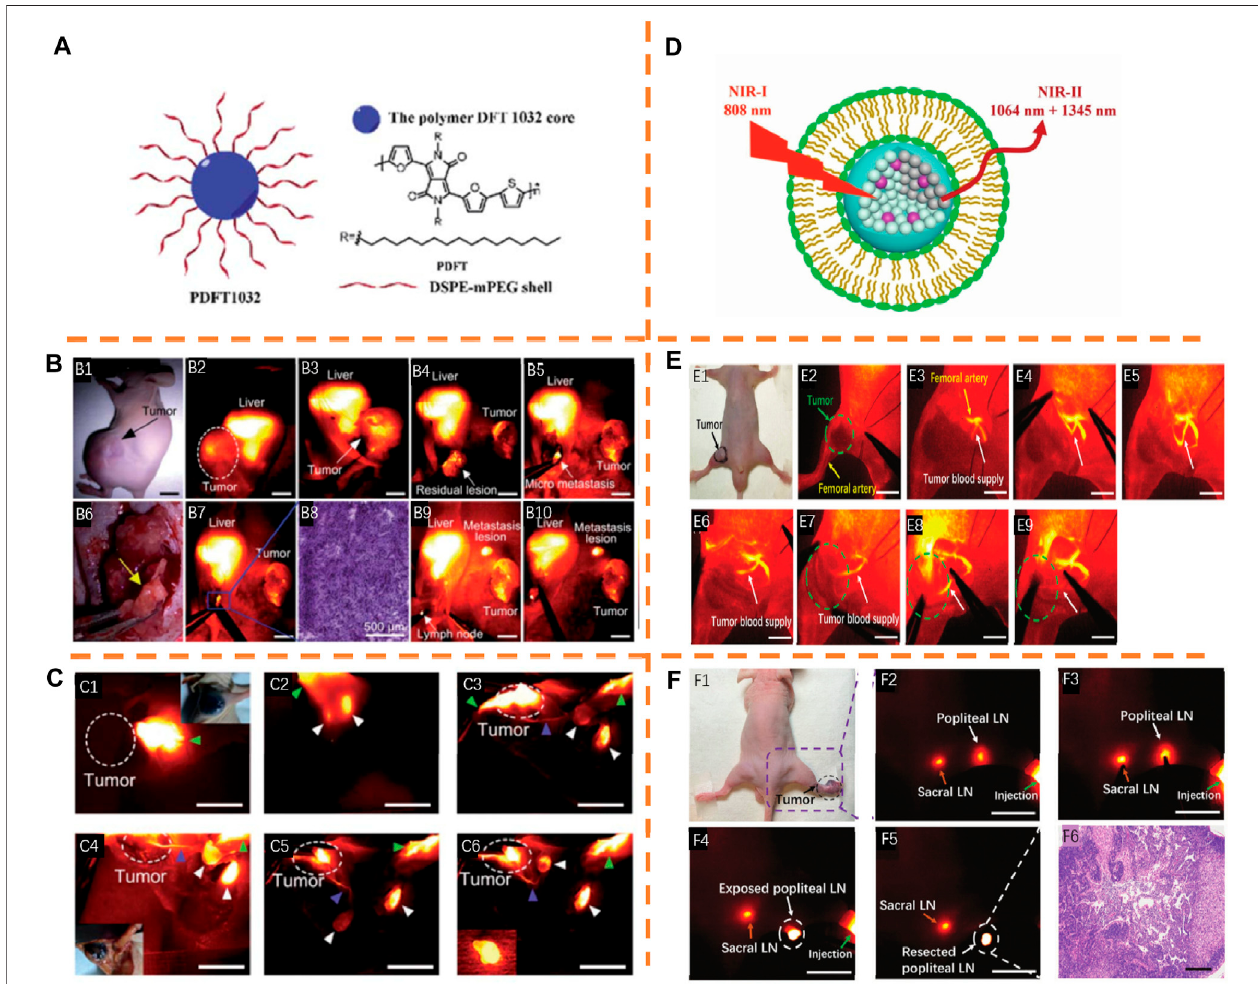
FIGURE 10 | (A) Schematic explanation of PDFT1032 fabrication. Adapted with consent from Shou et al. (2018). (B) B1 : Digital picture of nude mice with an orthotopic osteosarcoma. B2,B3 : NIR-II images of the whole tumor. B4 : Resection of the tumor body was performed. B5 : Mic-NIR-II imaging. B6 : Bright fi eld photo- metastasisofthetumor. B7 :NIR-IIimagingwasadoptedtofullyresectthemicro-metastasis. B8 :Histologicalanalysis.Thevisualizationandresectionofthelymphnode were conducted by virtue of PDFT1032 ( B9,B10 ). (C) C1 : Injection of PDFT1032 was administered at the margin of the B16F10 melanoma. C2 : After 10 min, the clear identi fi cation oftwoaxillary lymphnodeswasconducted. C3 – C5 :Theclear identi fi cation ofeffective lymphatic vessellinking thetumortothenodewasperformed. The distinct identi fi cation of the sentinel lymph node and the secondary lymph node was performed. C6 : Resection of the sentinel lymph node was performed (inserted image). (D) Schematic construction explanation of RENPs@Lips. Adapted with consent from Li et al. (2019). (E) E1 : Digital picture of nude mice with femur orthotopic osteosarcoma. E2 – E7 : Guided by NIR-II, the main blood supply of osteosarcoma was obviously distinguished from the femoral artery. E8,E9 : Interim blockage of